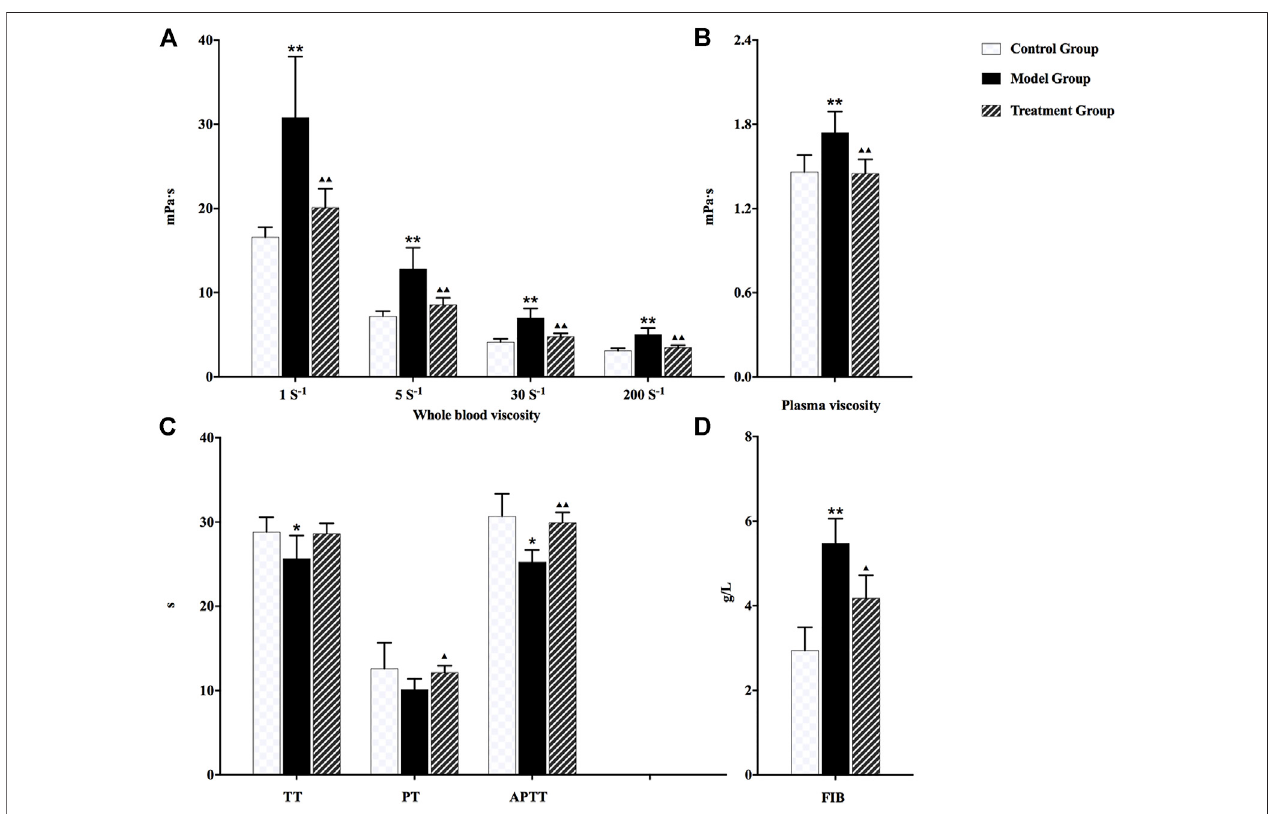
FIGURE1| Changesineachpharmacodynamicindexofratsindifferentgroups: (A) wholebloodviscosity, (B) plasmaviscosity, (C) TT,PT,andAPTT,and (D) FIB. ▲▲ p < 0.01 and ▲ p < 0.05 compared with the NHBS model group; * p < 0.05 and ** p < 0.01 compared with the control group.